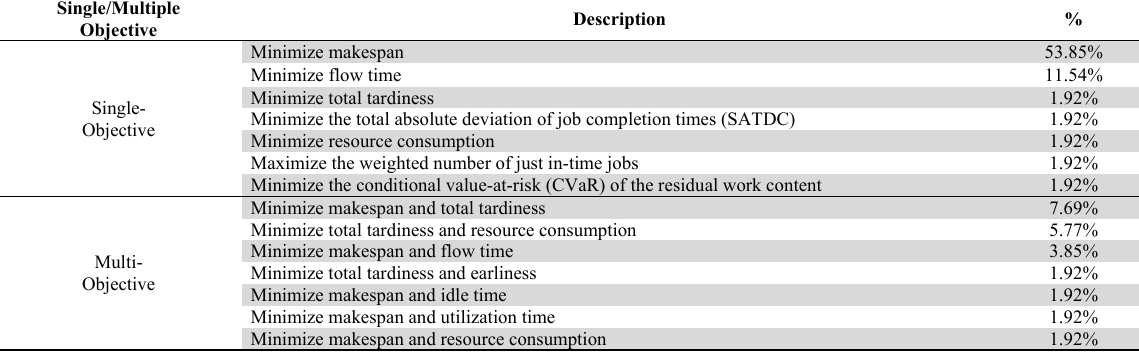
Objective and multi-objective NWFSP studied in the last five years. Made by the